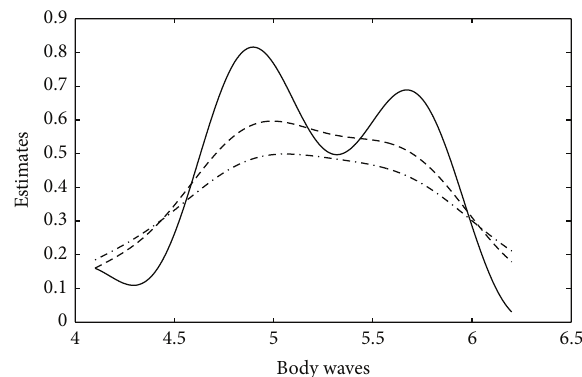
Figure 4: Estimates of density of body waves. The solid line is the estimate based on direct data, and the dashed and dot-dashed lines are the estimates under assumption on Laplace error with position parameter 𝛼 = 0 and scale parameters 𝜆 = 0.3 and 𝜆 = 0.5 ,